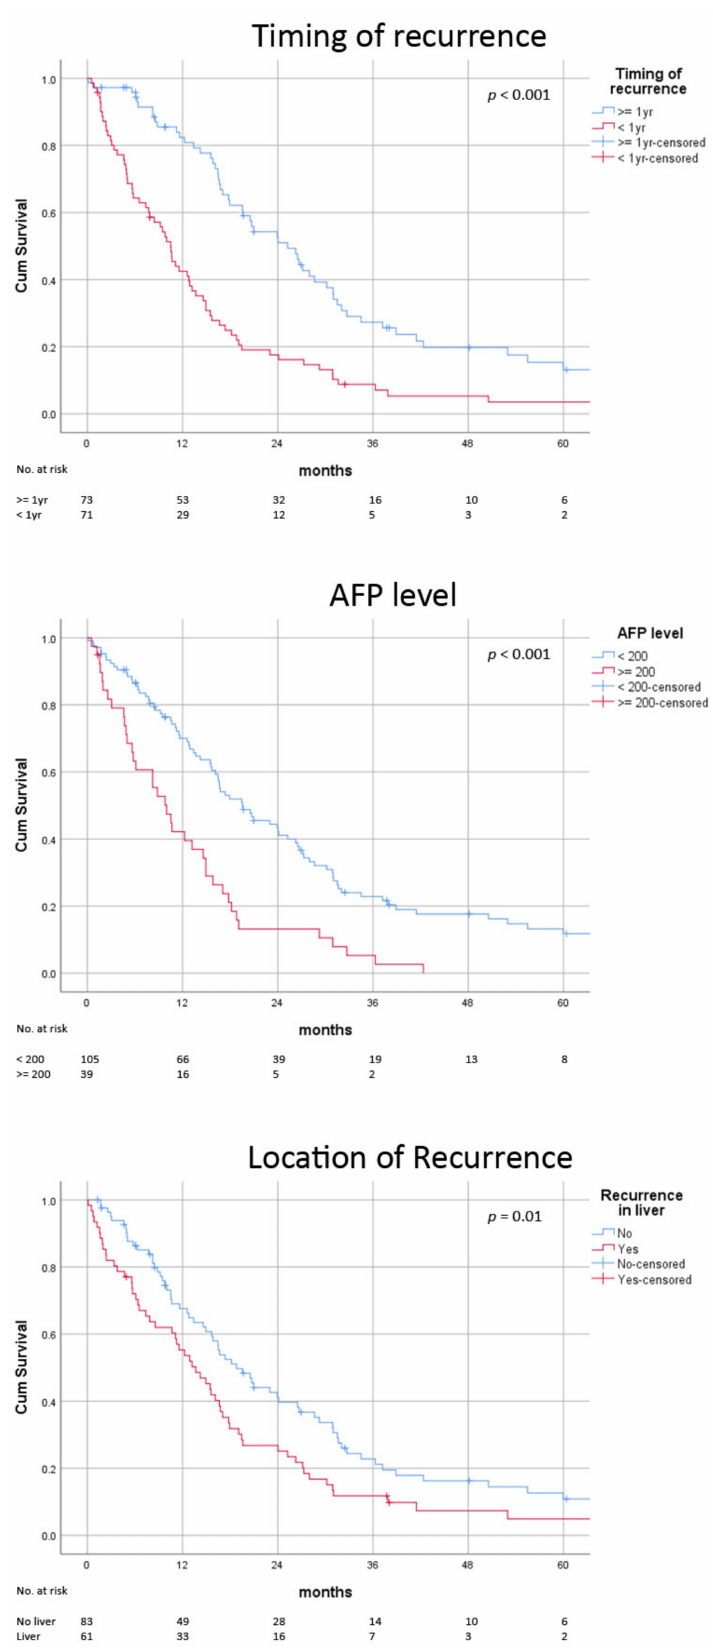
Figure 1. Post-recurrence survival stratified by biological risk